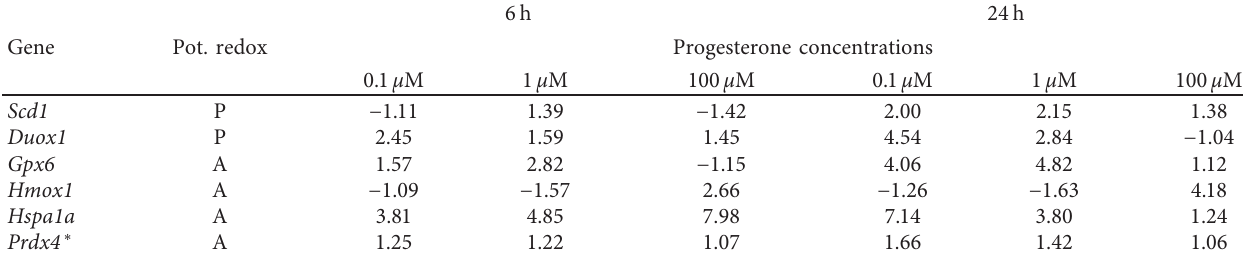
Table 2: Genes modulated by progesterone in RINm5F cells.